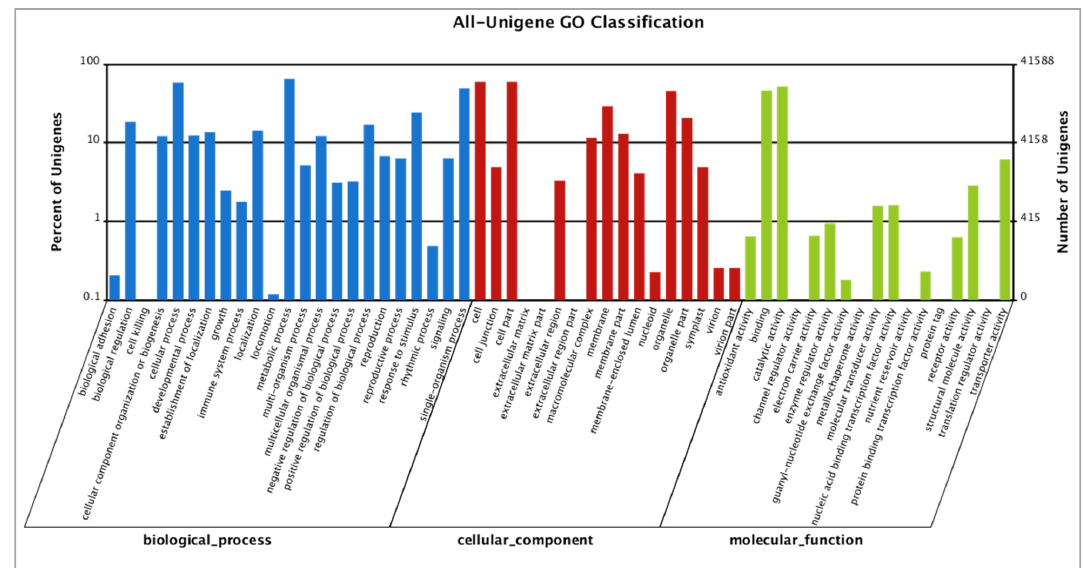
Figure 4. GO classification analysis of unigenes. GO functions are showed on the x-axis. The right y-axis shows the number of genes that have the GO function, and the left y-axis shows the percentage. Unigenes in the winter and spring season are classified into biological processes, cellular components, and molecular functions. In total, 41,588 (50.76% of all unigenes) were assigned to 48 GO categories.